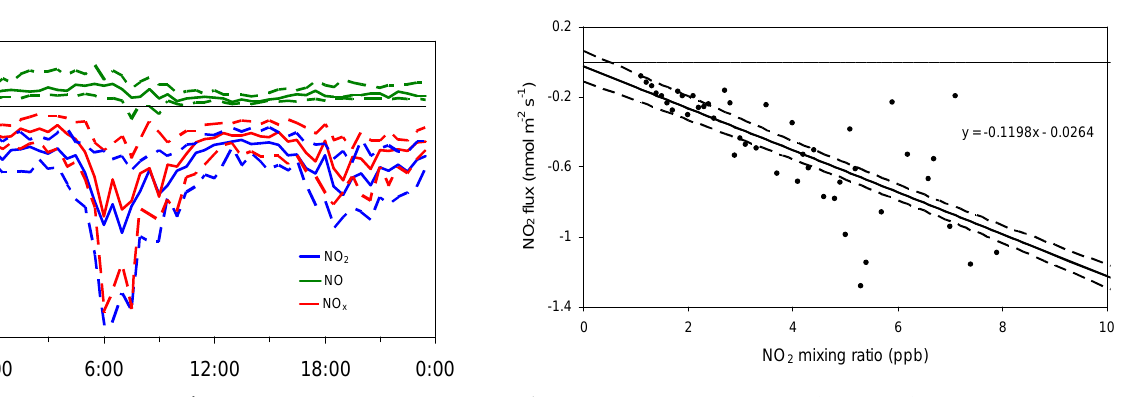
Fig. 9. Measured NO 2 flux as a function of the NO 2 mixing ratio Figure 9: Measured NO 2 flux as a function of the NO 2 mixing ratio (z = 2.0 m) from 29 2 ( z = 2 . 0m) from 29 August to 20 September 2005. Solid and dotted August to 20 September 2005. Solid and dotted lines are the regression line and its 95% 3 lines are the regression line and its 95% confidence interval, respec- confidence interval, respectively. NO 2 fluxes were corrected for chemical reactions above the 4 tively. NO 2 fluxes were corrected for chemical reactions above the canopy and averaged for NO 2 mixing ratio bins of 0.1 ppb. Only data for G r > 400 W m -2 5 canopy and averaged for NO 2 mixing ratio bins of 0.1ppb. Only were included. 6 data for G r > 400Wm − 2 were